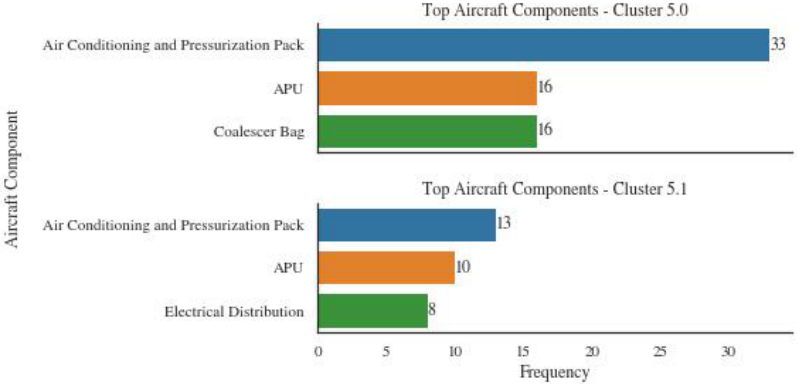
Figure 8. Cluster 5 Subclusters’ Aircraft Component Metadata Trends.